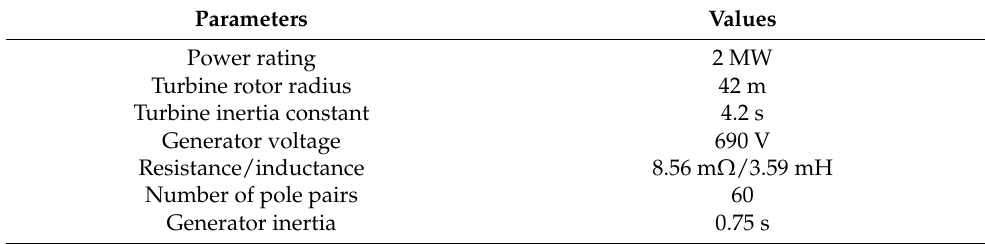
Table 2. Specifications of turbine and PMSG.